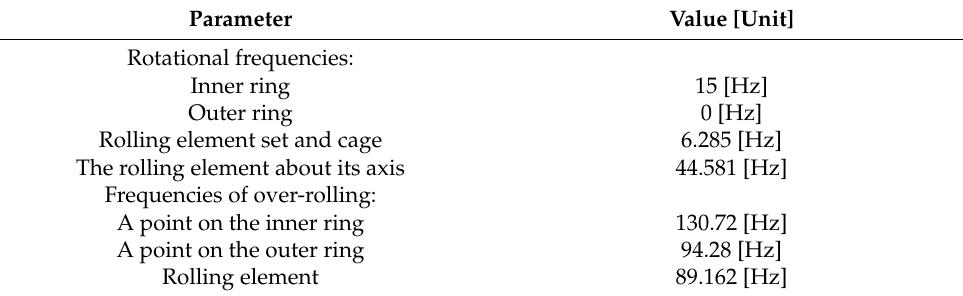
Table 4. Frequencies of ball bearing SKF 1207K EKTN9 [90].